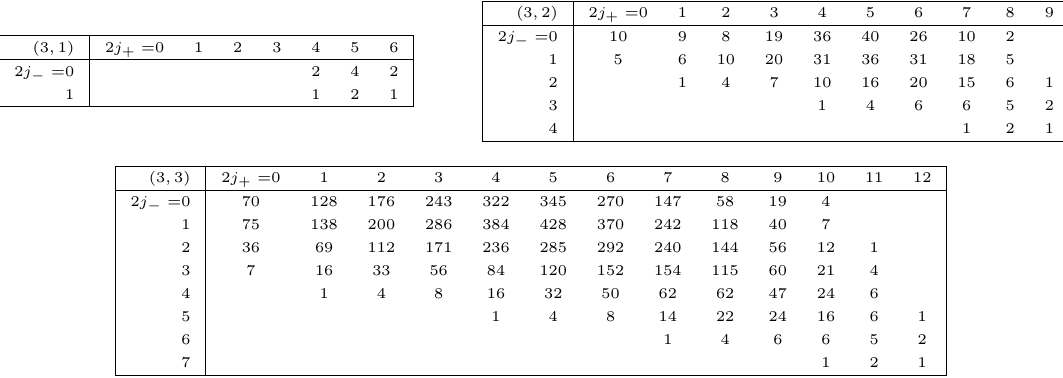
Table 13 . BPS numbers of massless M-string at base degree 3 and fiber degree up to 3.